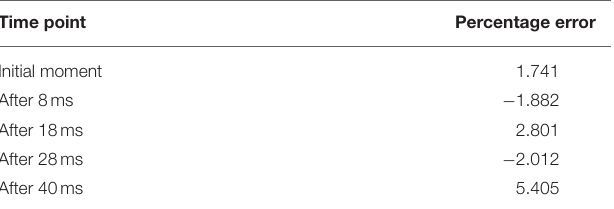
TABLE 1 | Comparison of experimental results with results obtained using numerical simulation; the percentage error of the area of the cross-section of the RBC obtained in numerical simulation, compared to the value of area calculated from experimental data, for the first initial position of the RBC.